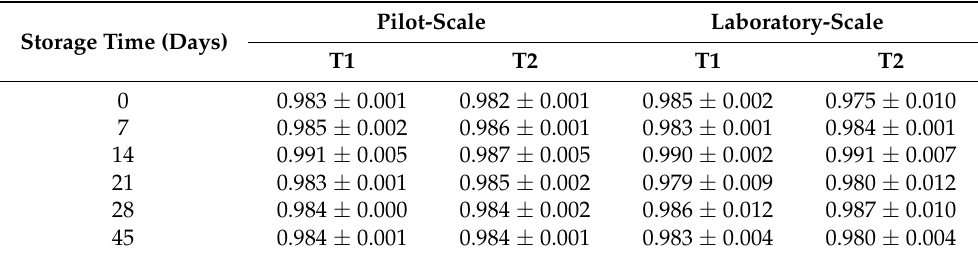
Table 2. The Aw results were obtained according to the methods, treatments and storage time applied to blank processed cheese